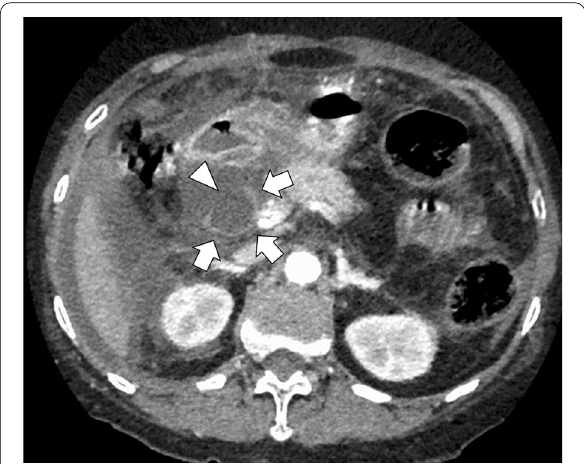
Fig.1 Preoperative computed tomography (axial view). Enhanced computed tomography showed a dilated common bile duct (arrow) with a partial defect in continuity (arrowhead) and peritoneal fluid around the